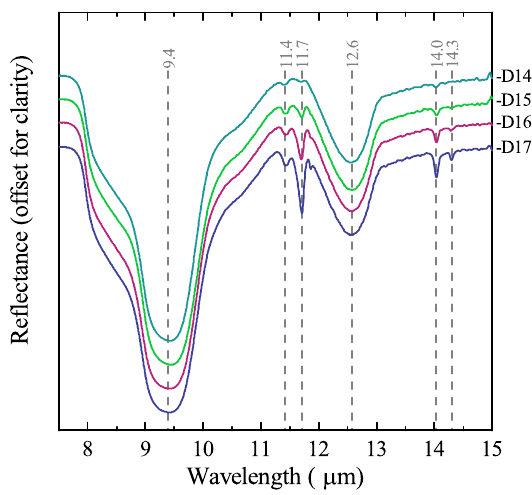
Figure 4. Attenuated total reflection (ATR) infrared (IR) spectra of diatomite ore samples with variable content of CaCO 3 : D14 = 6.29 wt %, D15 = 10.9 wt %, D16 = 16.4 wt %, D17 = 24.4 wt